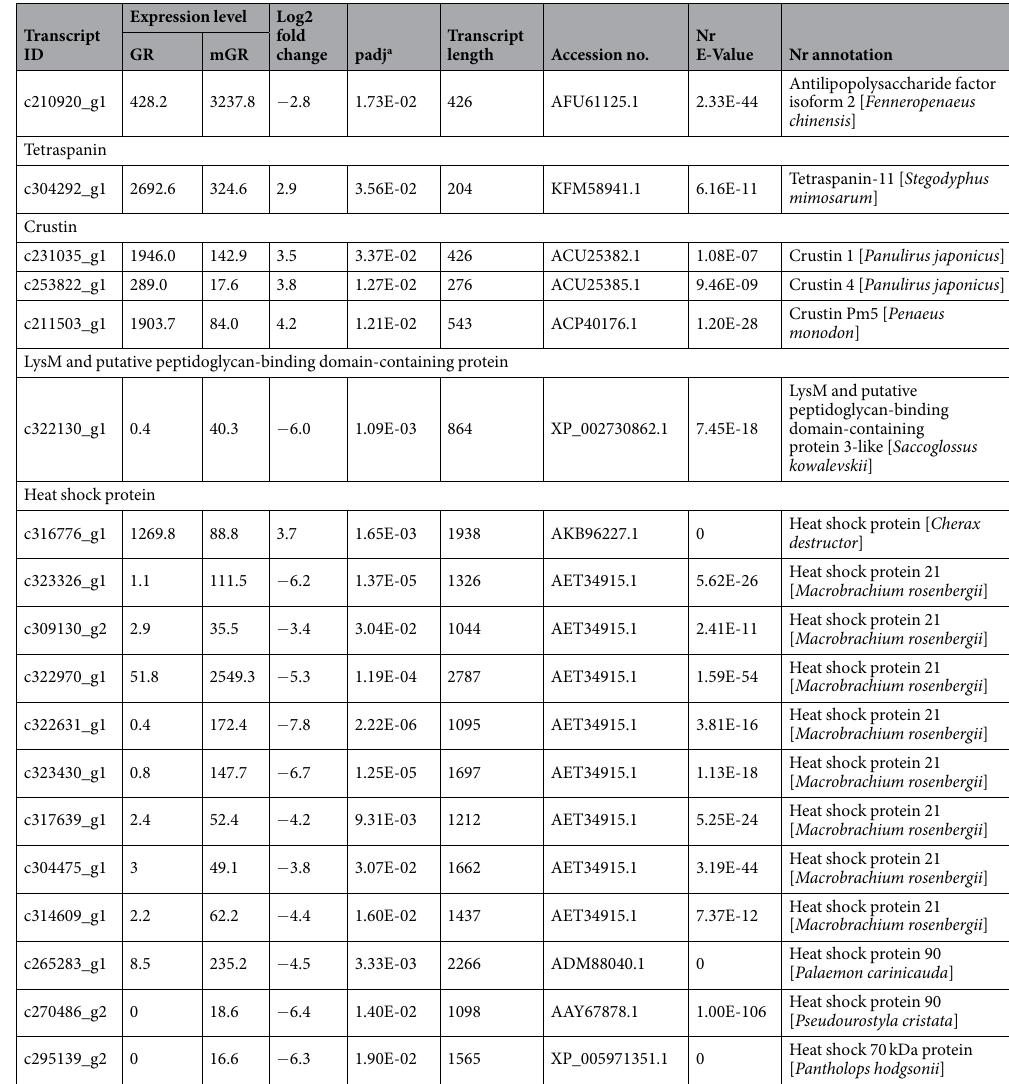
Table 3. Summary of DEGs involved in sulfur metabolism, antioxidation and detoxification, and immunity. a Padj, P adjusted value.